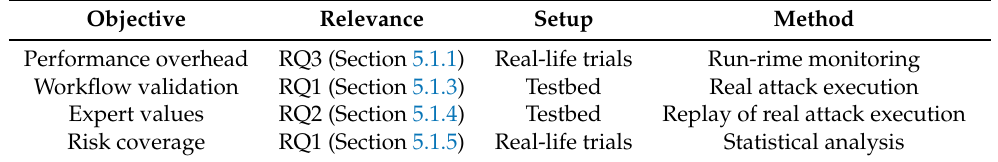
Table 6. Experimental validation